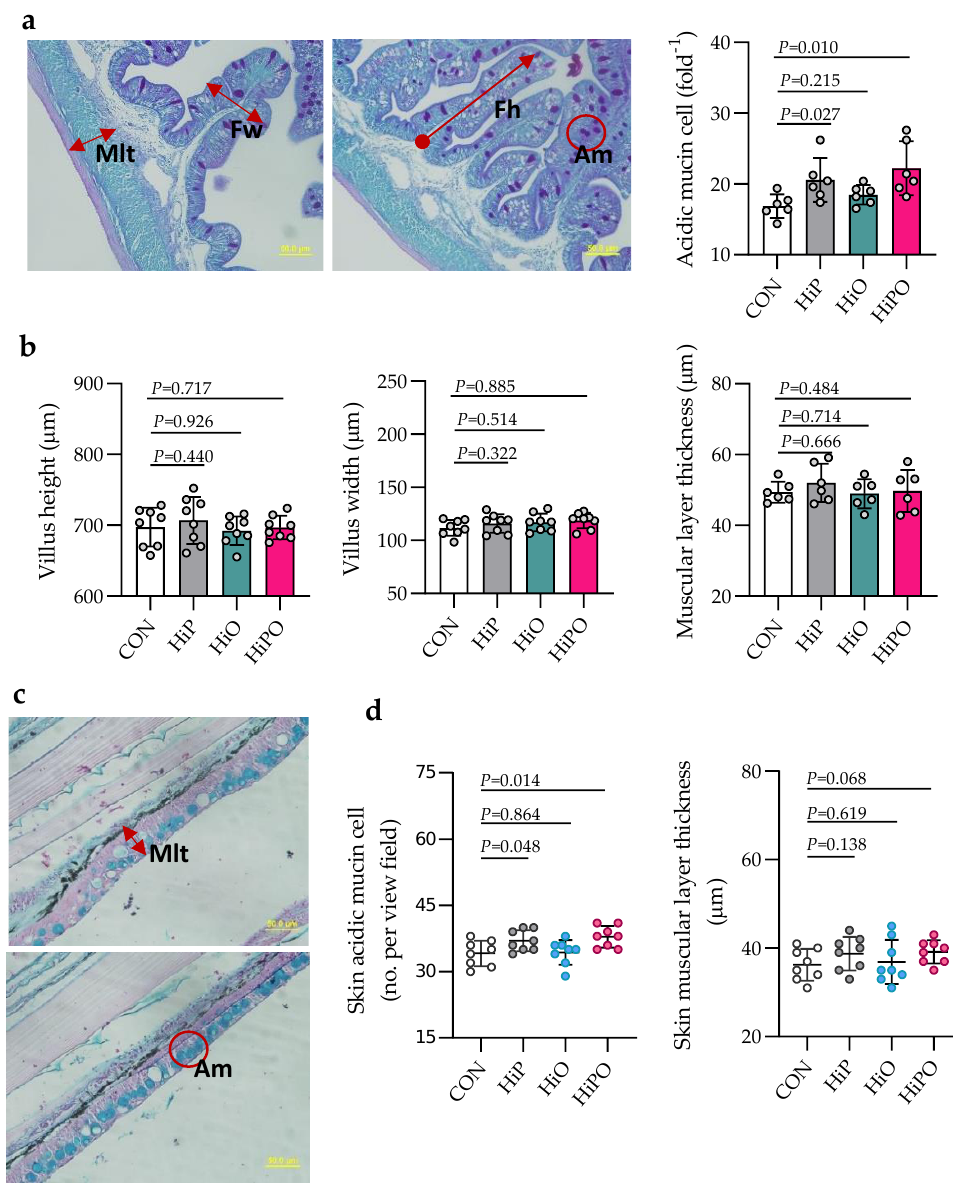
Figure 4. Gut and skin mucosal morphology of barramundi fed partially defatted BSF larvae protein and oil as FM protein and oil replacement diets. ( a ) Schematic representation of histometric measurement of muscular layer thickness (Mlt), fold height (Fh), fold width (Fw), and acidic mucins (Am) of distal gut (PAS, 40 × magnification, scale bar 50 µ m). ( b ) Quantification of Mlt, Fh, Fw, and Sam of the distal gut of barramundi. ( c , d ) Skin histometric measurement and quantification of skin muscular layer thickness (Mlt) and number of skin acidic mucin (Am) (Alcian Blue pH 2.5 stain, 40 × magnification). Data were expressed as mean ± SE, n = 6. Bar with p -value denotes significant level among the experimental treatments (one-way ANOVA; Tukey post-hoc test; significant at p >